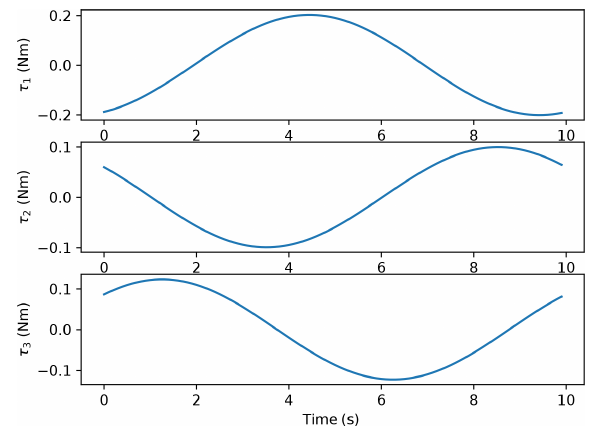
Figure 16. Gravity compensation-required torques. Table 2. Gravity compensation model parameters.